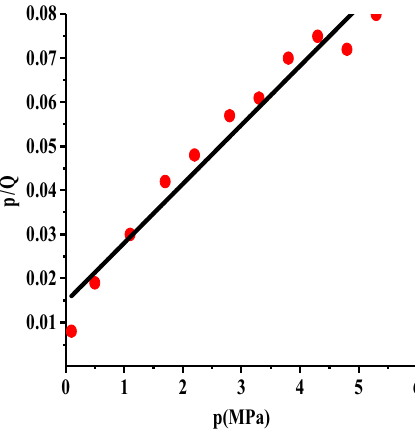
Fig. 11 p = Q – p and adsorption constant of number 6